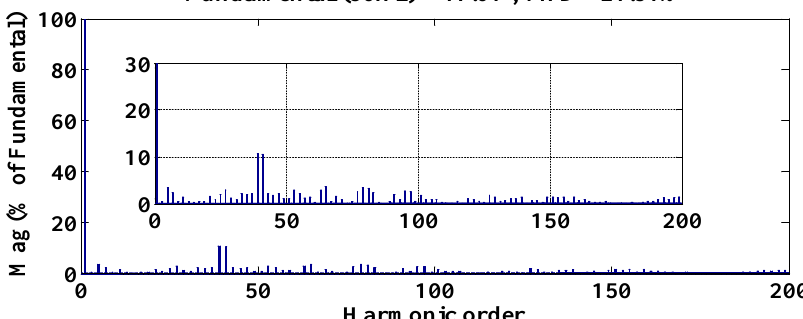
Figure 8. Fast Fourier transform ( FFT) plot for the output voltage of the PDPWM strategy. Energies 2018 , 11